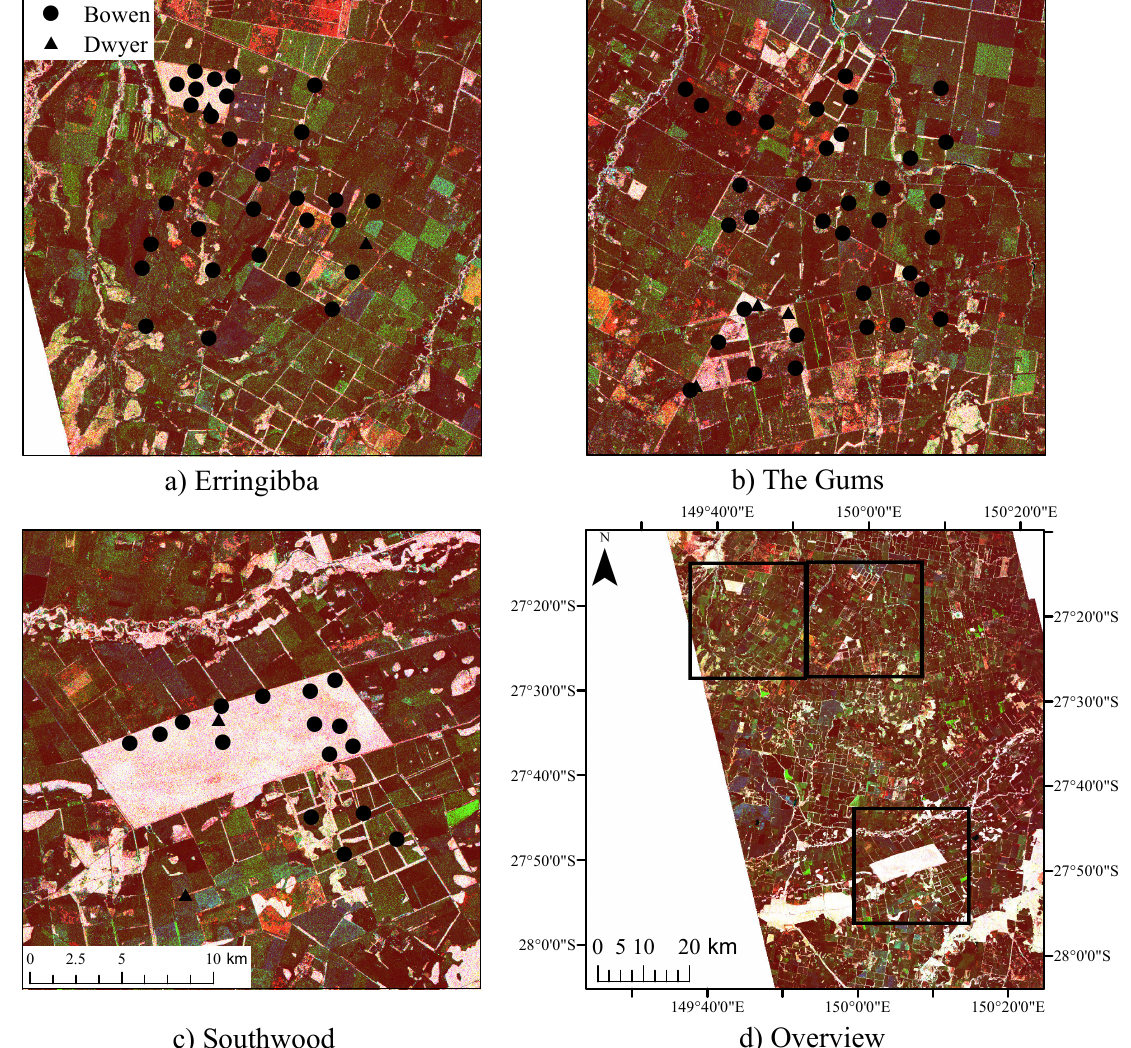
Figure 1. The location of transects inventoried by Bowen et al. [6] and Dwyer et al. [7]. Data were collected from three key areas within the Tara Downs subregion; ( a ) Erringibba, ( b ) The Gums and ( c ) Southwood. An overview of the subregion is given in ( d ). The background image is a composite of Landsat FPC (red) and ALOS PALSAR HH- (green) and HV-polarisation (blue) data from 2008. Areas of regrowth, with a high value of FPC but low values of L-band HH and HV, appear red whilst mature forest (as in Southwood National Park) appears white because of the comparatively higher values in all three